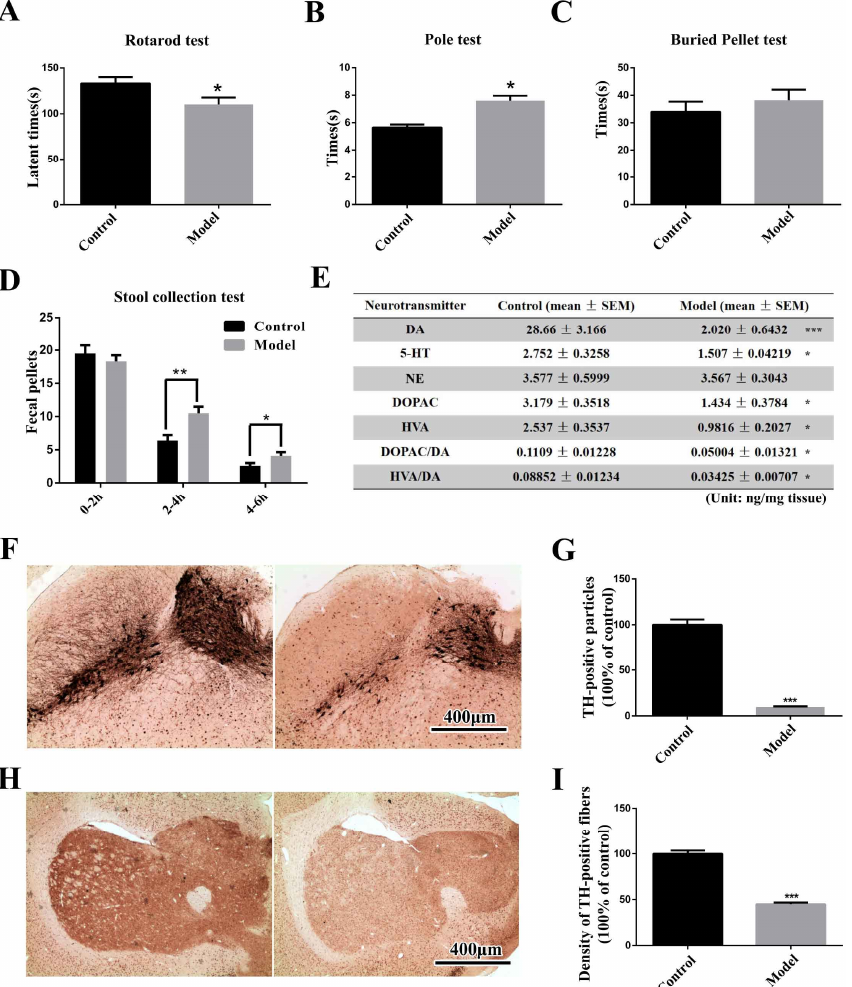
Figure 1. Motor, gastrointestinal and pathological alterations in chronic MPTP/p-induced PD mice. ( A ) Rotarod test performance across groups. ( B ) Pole test performance across groups. ( C ) Olfactory capacities across groups, as measured via the buried pellet test. ( D ) Stool frequency during 6 h across groups. ( E ) A table representing the expression levels of the main neurotransmitters and their metabolites in the STR across groups is shown. ( F , H ) Two representative photomicrographs of TH- immunoreactive particles in the SN and STR (scale bar = 400 μm). ( G , I ) Two histograms representing the respective quantitative analysis of TH-positive particles in the SN and STR normalized to control levels are shown. (* p < 0.05; ** p < 0.01; *** p < 0.001)